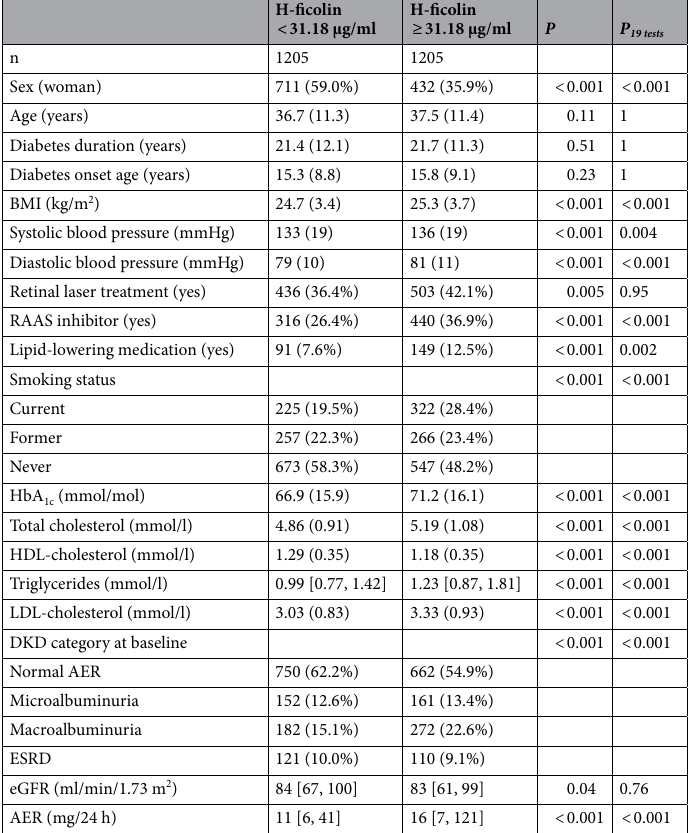
Table 1. Baseline characteristics by median H-Ficolin concentration. Data are presented as mean (standard deviation), median [interquartile range], or n (%). P 19 tests , p-value after Bonferroni correction for the total number of tests; BMI, body mass index; RAAS, renin–angiotensin–aldosterone system; HbA 1c , glycated hemoglobin; HDL, high-density lipoprotein; LDL, low-density lipoprotein, DKD, diabetic kidney disease; AER, albumin excretion rate; ESRD, end-stage renal disease; eGFR, estimated glomerular filtration